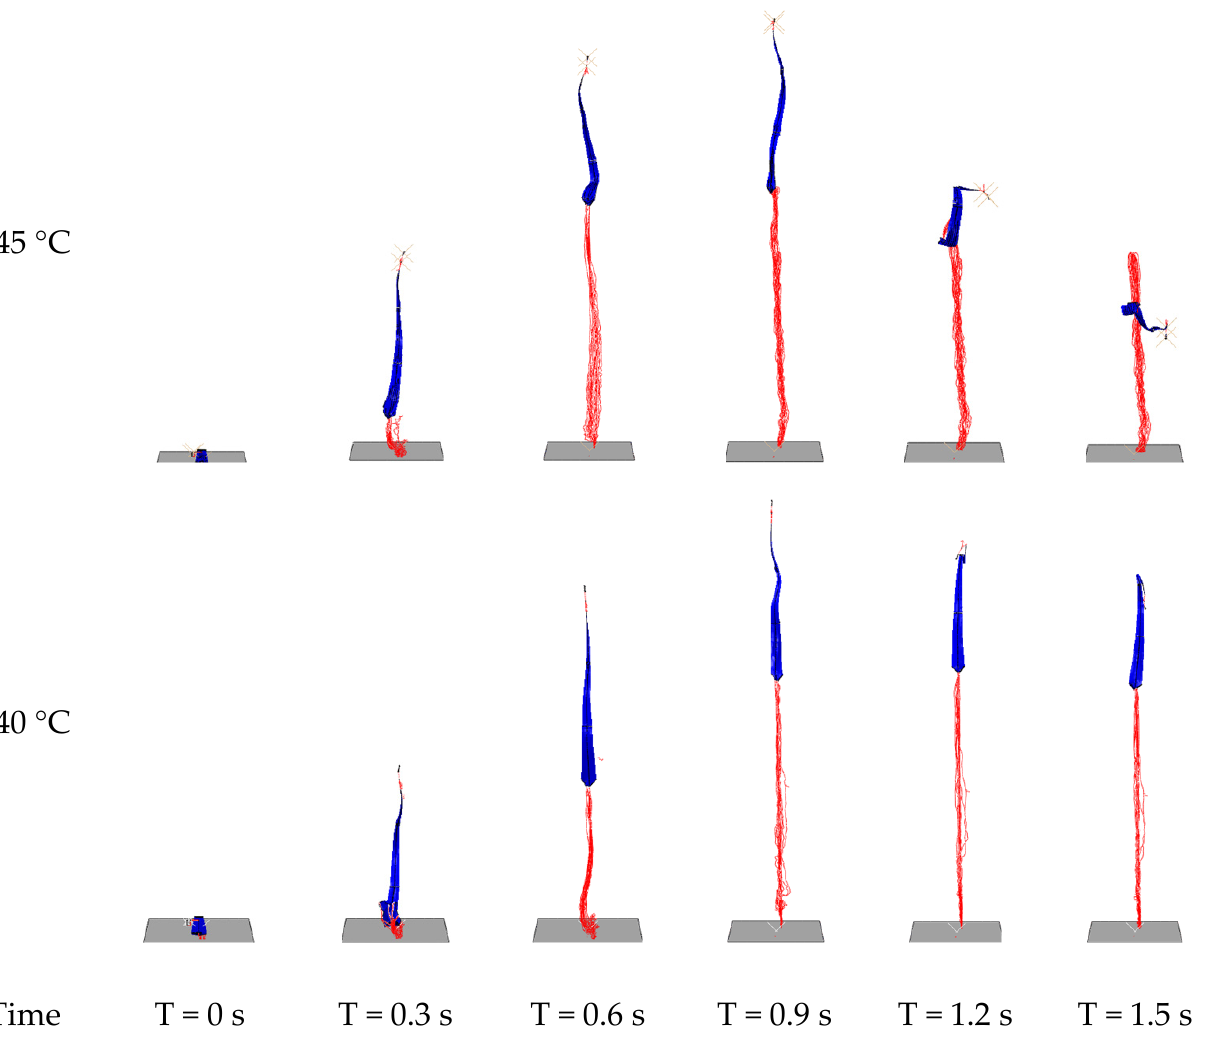
Figure 19. Different temperature parachute deployment process.